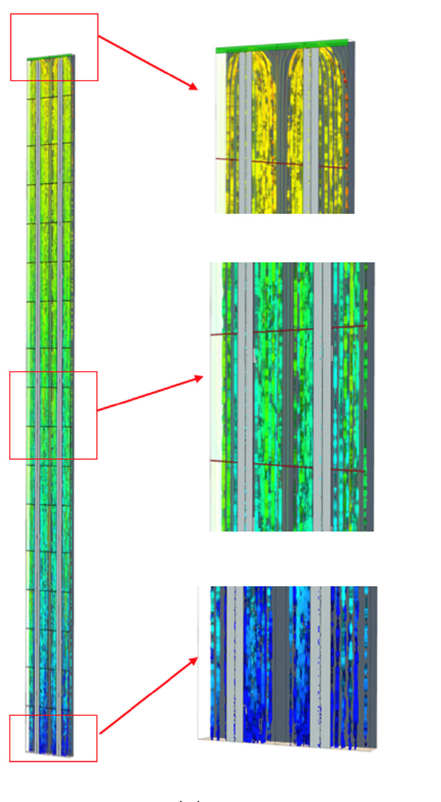
Figure 14. ( a ) Visualization of streamlines in ventilated gap of façade—3D view. ( b ) Visualization of temperature field in façade vertical cross section in winter temperature extreme.